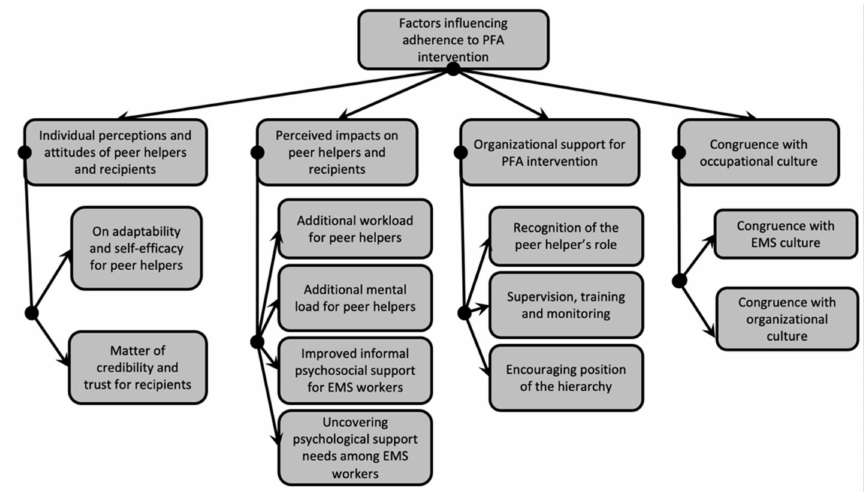
Figure 1. Themes and subthemes following thematic